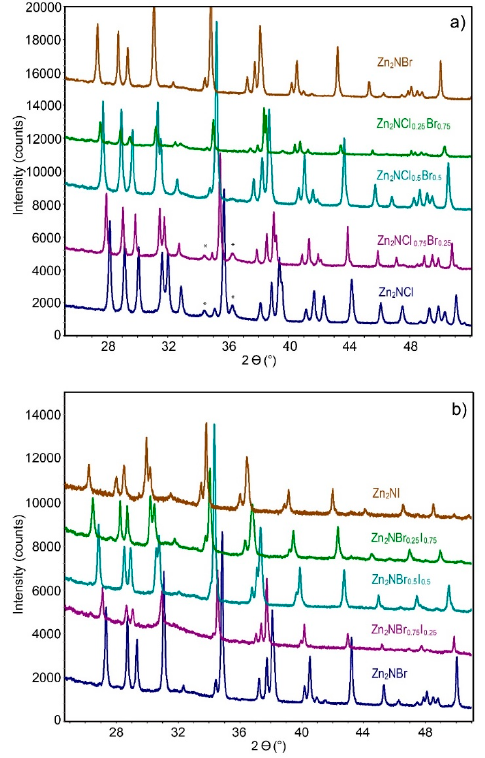
Figure 2. PXRD patterns of zinc nitride halides Zn 2 NCl 1 − y Br y ( a ) and Zn 2 NBr 1 − y I y ( b ) with 0 ≤ y ≤ 1. Two samples Zn 2 NCl 0.75 Br 0.25 and Zn 2 NCl within ( a ) contain small amount ZnO